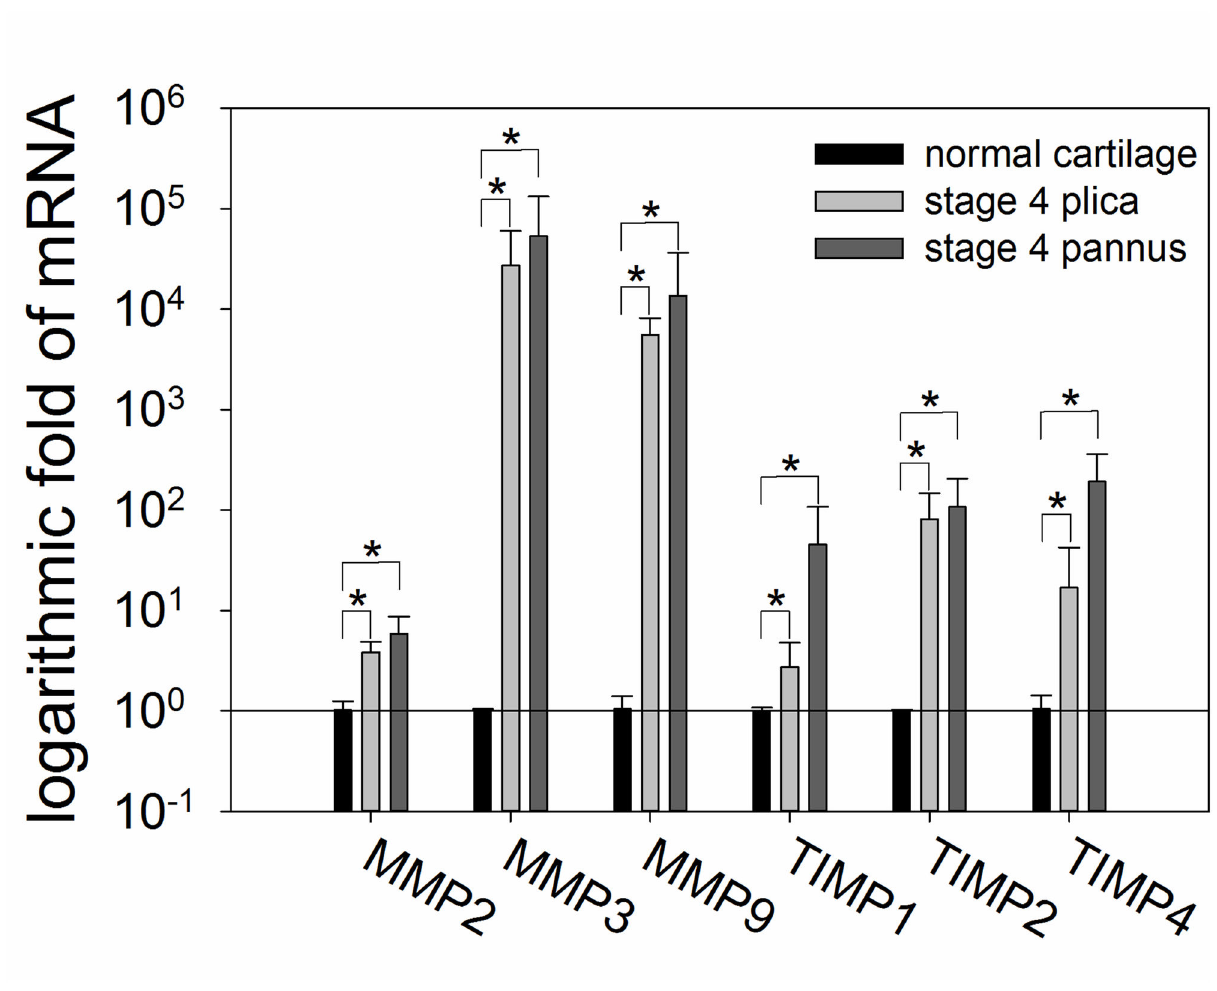
Figure 2. Real-time polymerase chain reaction measurement of mRNA levels for the indicated MMPs and TIMPs in medial plica and pannus-like tissue from knees from patients with stage IV OA and in normal cartilage. Total RNA was isolated from the medial plica and pannus-like tissue of stage IV OA knees (N = 15 for both) or normal cartilage (N = 3) and mRNA levels for the indicated MMPs and TIMPs measured by real-time PCR and expressed relative to that in normal cartilage. Each bar represents the mean ± standard deviation (SD), * P <